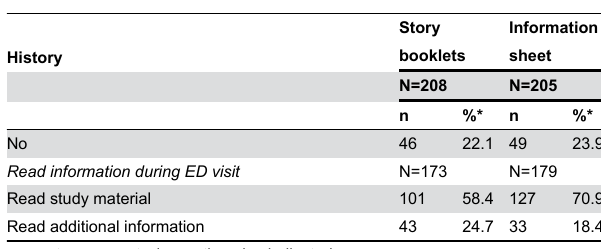
Table 4. History of previous illness, severity of illness at baseline, and ED visit.